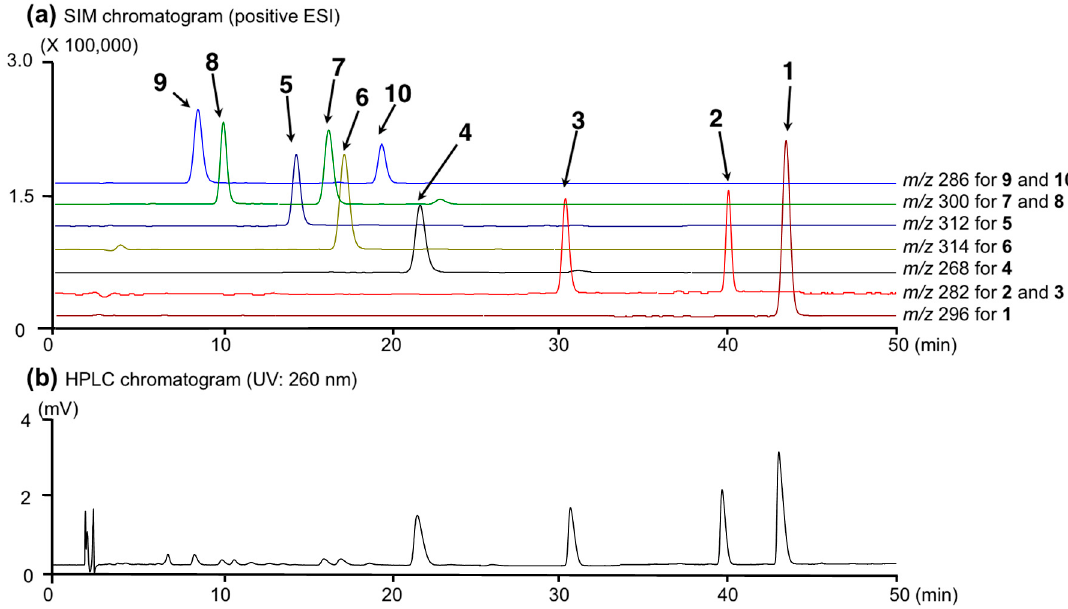
Figure 2. A typical LC-MS chromatogram of a standard solution mixture (each 10 µg/mL) of alkaloids ( 1 – 10 ). ( a ) SIM chromatogram (positive ESI); ( b ) HPLC chromatogram (UV: 260 nm).